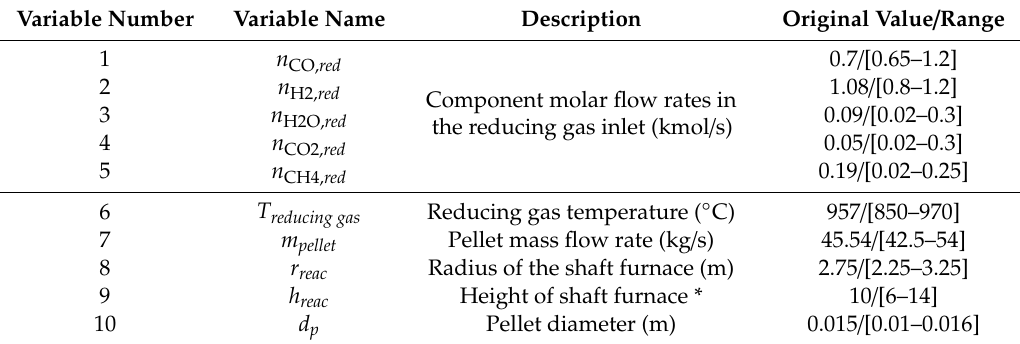
Table 2. Optimization